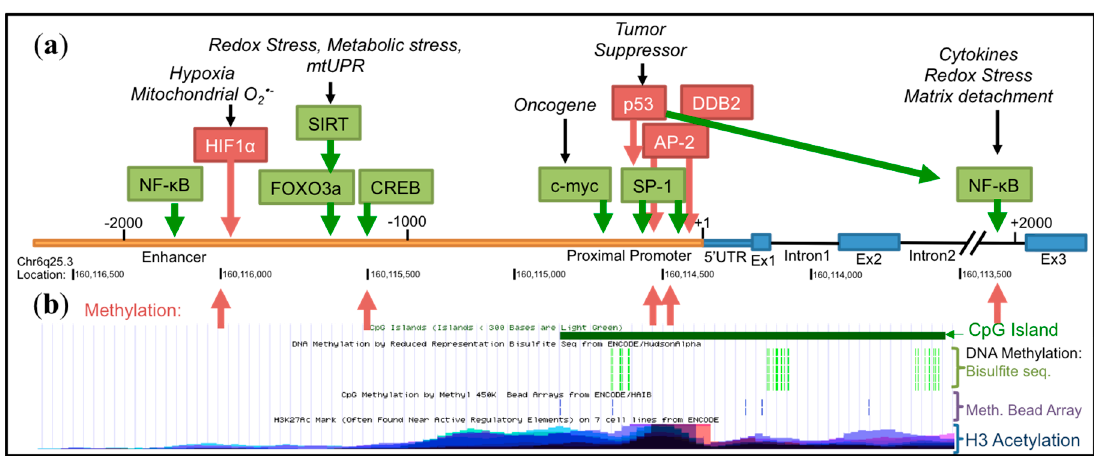
Figure 3. The SOD2 promoter. ( a ) Transcription factors that activate SOD2 transcription are shown in green, while repressors are represented in red. The promoter contains a proximal promoter and 5 ′ and intronic enhancer regions. ( b ) Red arrows show areas of demonstrated DNA methylation. Corresponding University of California Santa Cruz (UCSC) Genome Browser data (Human Assembly GRCh37/hg19, Chr 6q25.3; note: SOD2 is located on the reverse strand) demonstrate the location of the CpG island spanning the proximal promoter to Intron 2 and confirmed DNA methylation marks from bisulfite sequencing and methylation bead arrays. Areas of acetylated H3 histone association are also shown.